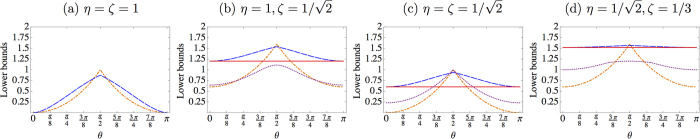
Graphs illustrate the lower bounds  (orange dot-dashed lines),  (blue dashed lines), −logC (purple dotted lines), and (red solid lines) for spin observables Xη and Zζ with respect to angle θ.In Figure (a), we denote −logC and  together by orange dot-dashed lines. And four the other graphs are sequentially presented for different unsharpnesses, and accordingly it is observed that the bounds become larger as unsharpness increases. We can analyze their behaviors as comparing the bounds to device uncertainty, and it is identified that −logC is strictly lower than device uncertainty at large unsharpness.